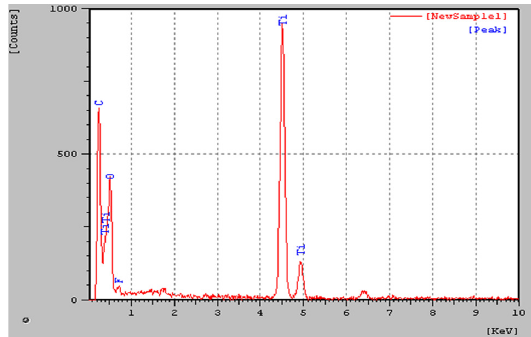
Figure 18. EDS analysis of TiC coated diamond in point 03 of Figure 15.